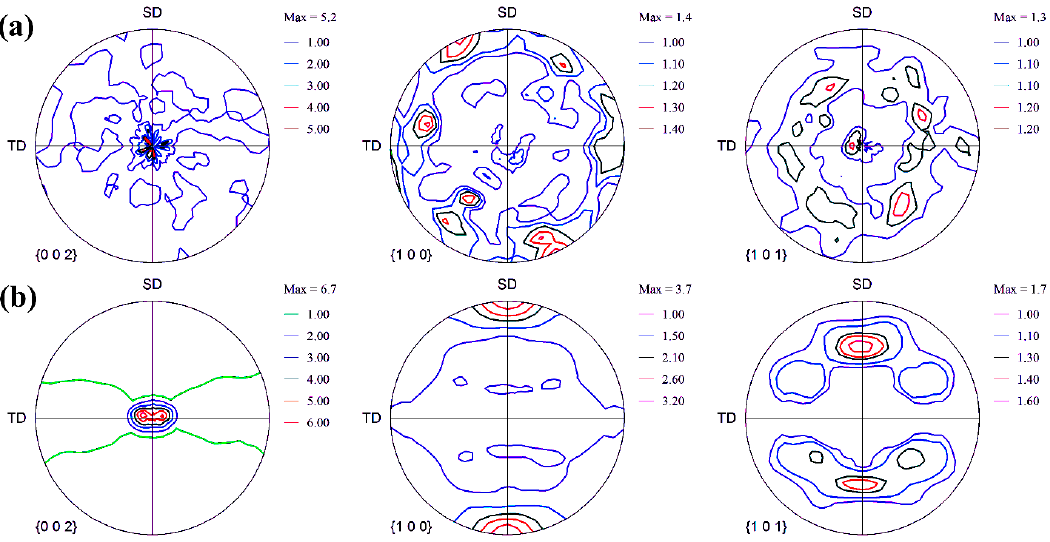
Figure 11. Pole figures of SD samples crept at 150 °C: ( a ) unreinforced alloy, and ( b ) composite